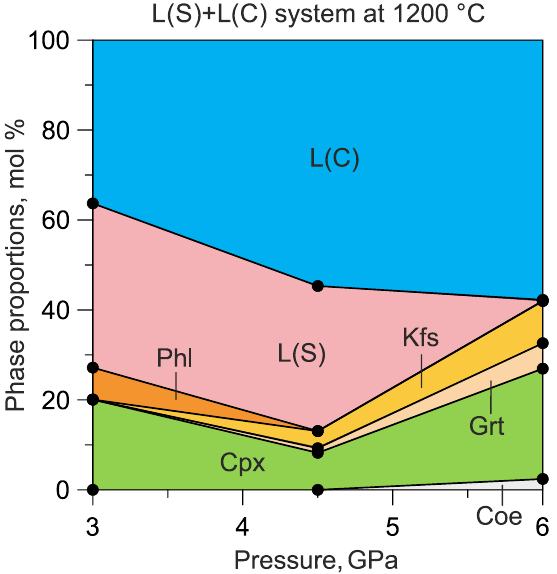
Figure 3. Calculated modes in mole fractions (Tables 2 and S2) of the phases in the system L(S)+L(C) as a function of pressure at 1200 °C.